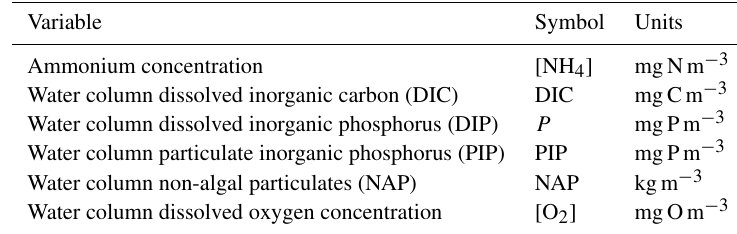
Table 8. State and derived variables for the water column inorganic chemistry model.